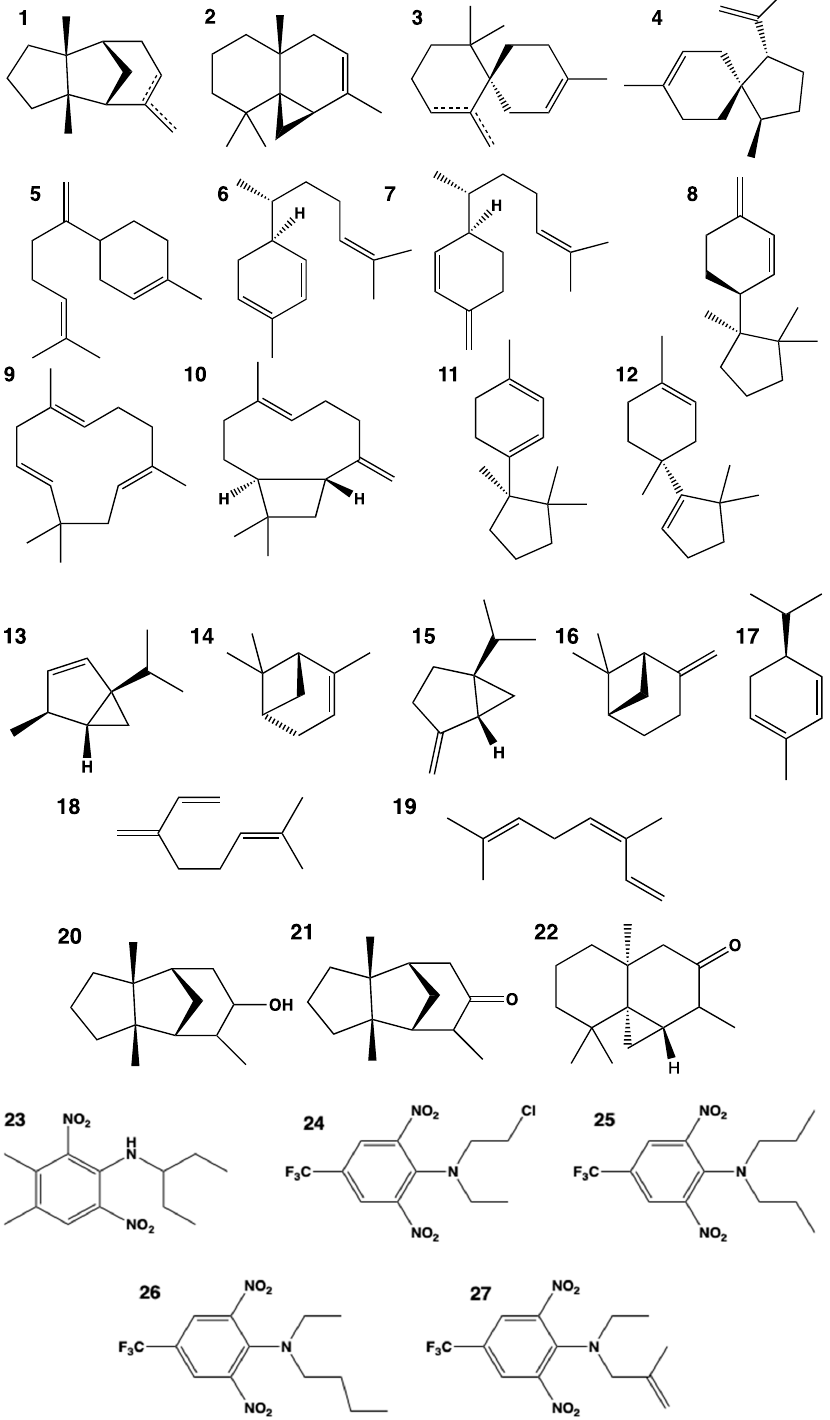
Figure 2. Natural and herbicide substrates of CYP706A3. Sesquiterpenes: 1 : (+)- α -barbatene and